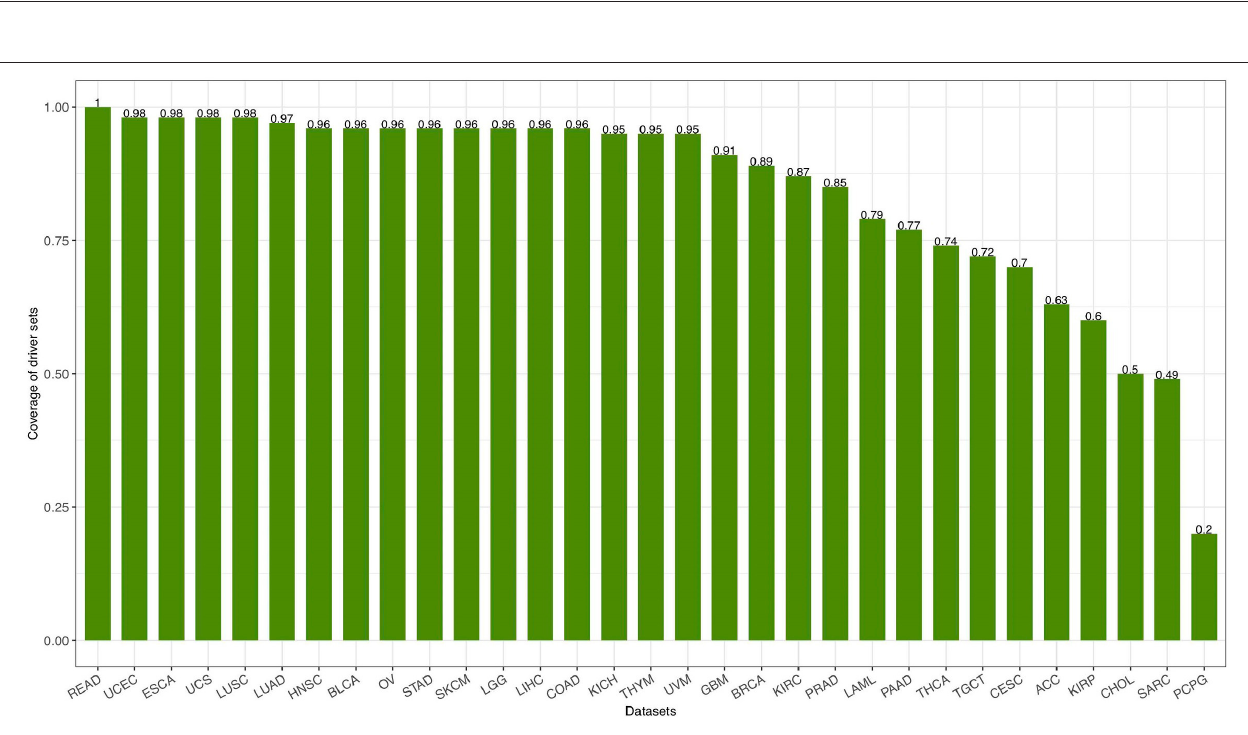
Frontiers in Genetics |